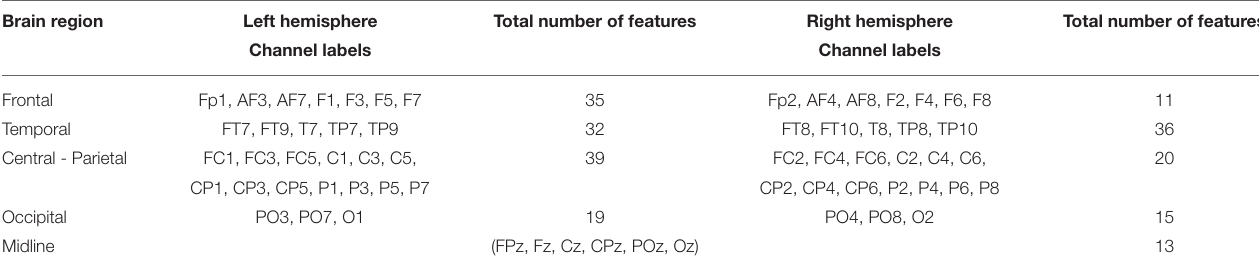
TABLE 3 | Extraction of the highest-ranked features for classification from the time-frequency analysis across participants separated after brain region and left/right hemisphere. Brain region Left hemisphere Total number of features Right hemisphere Total number of features Channel labels Channel labels Frontal Fp1, AF3, AF7, F1, F3, F5, F7 35 Fp2, AF4, AF8, F2, F4, F6, F8 11 Temporal 32